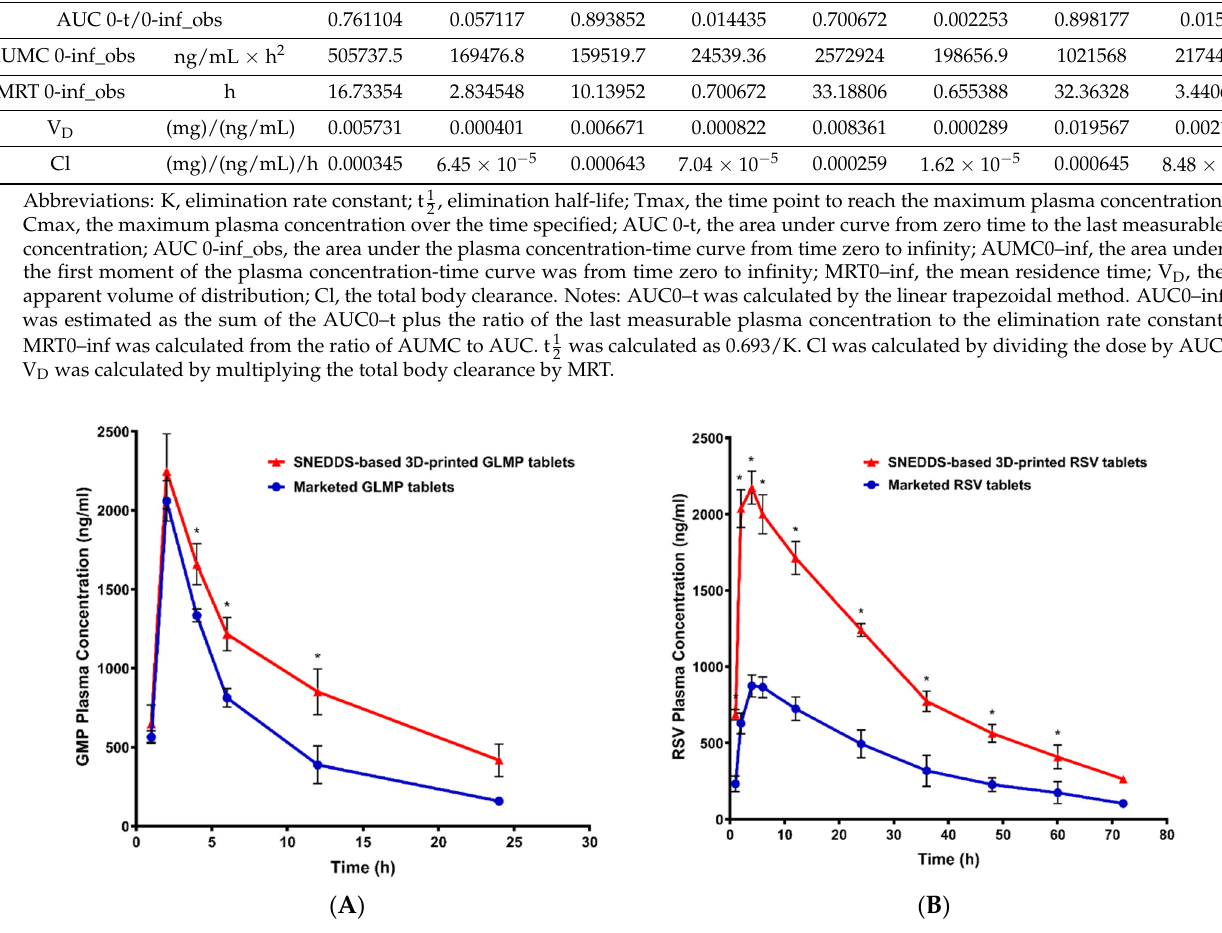
Parameter Parameter